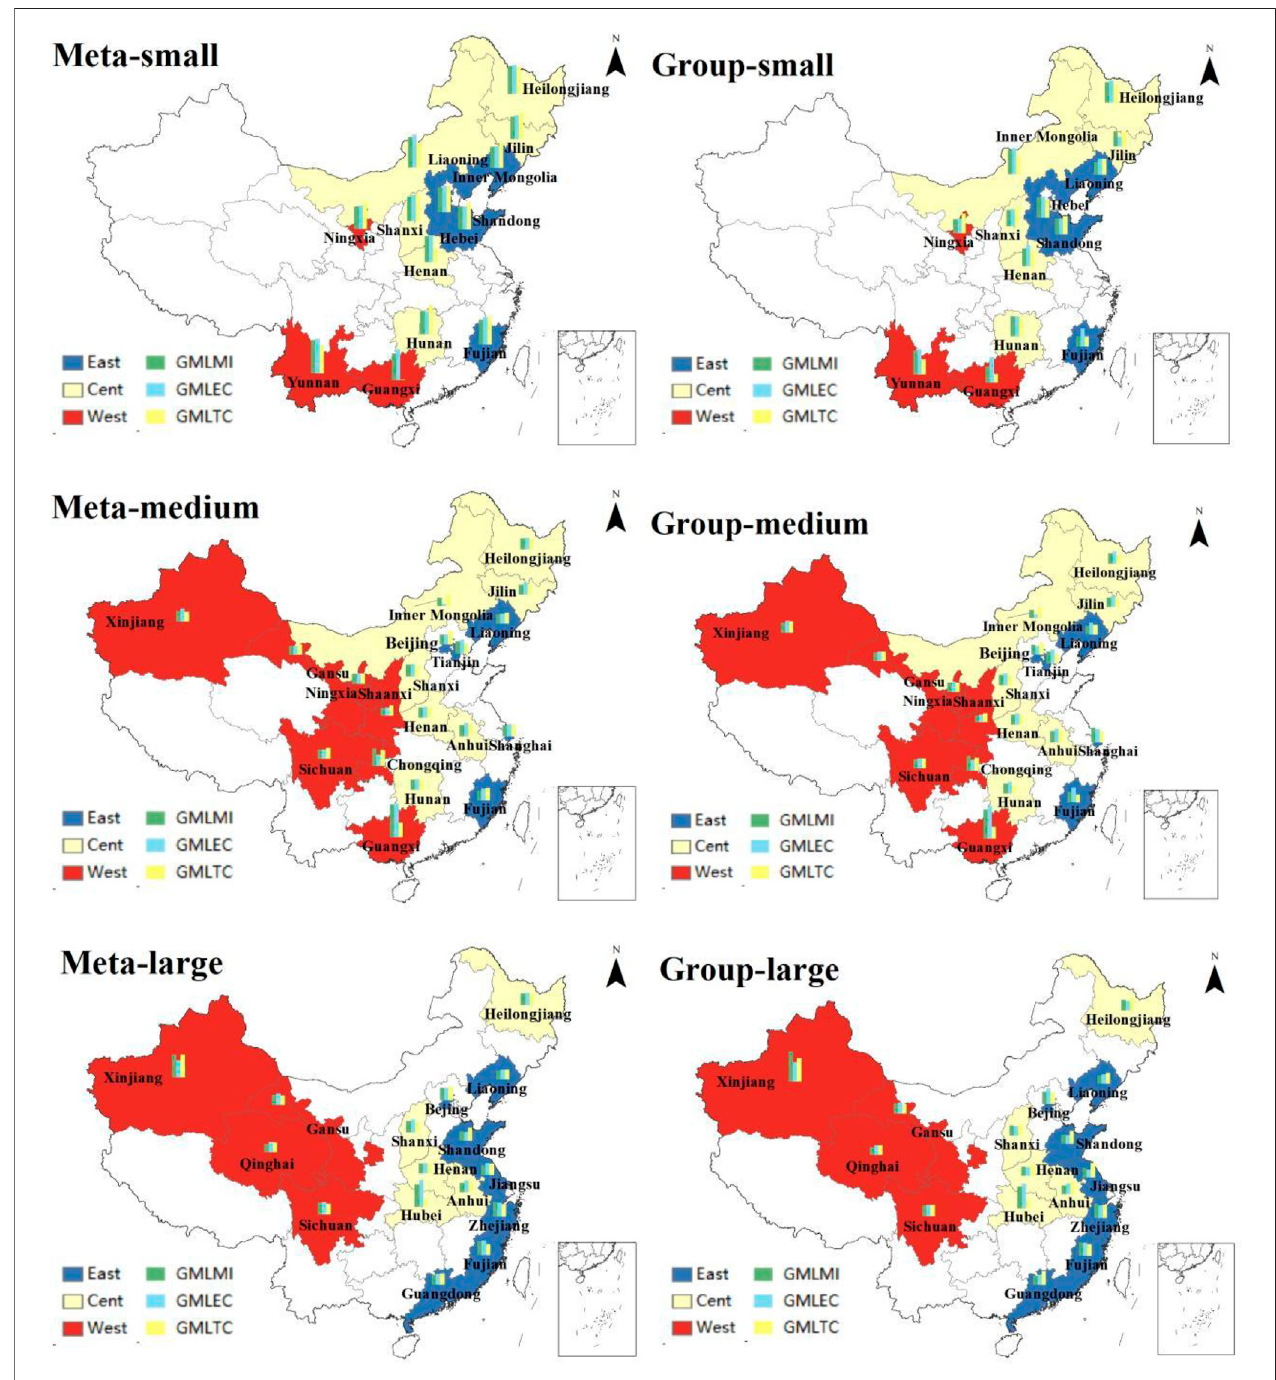
FIGURE 9 | Three-sized average GMLMI and its decomposition index in different regions.